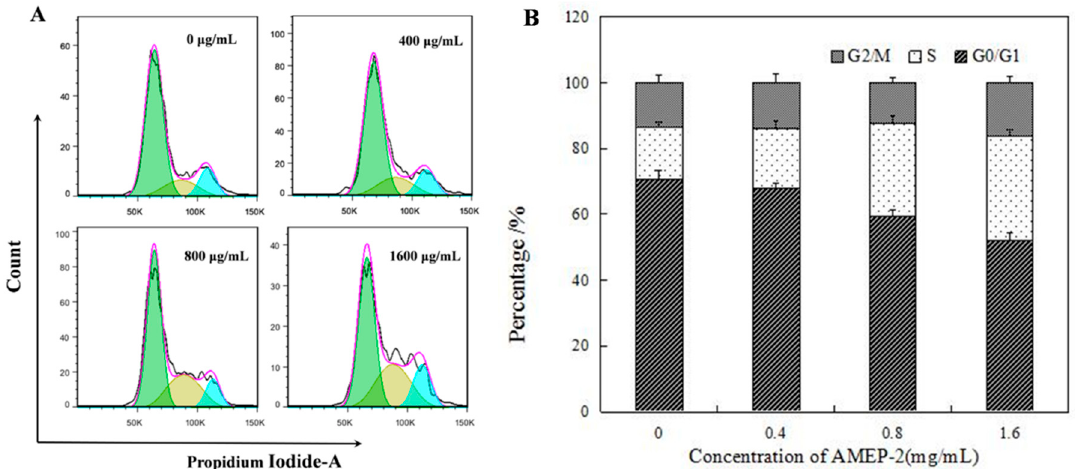
Figure 5. Effects of AMEP-2 on the cell cycle in BGC-823 cells: ( A ) Effects of AMEP-2 on the cell cycle in BGC-823 cells by Flow cytometry; ( B ) Percentage Chart of the Effects of AMEP-2 on the cell cycle in BGC-823 cells.